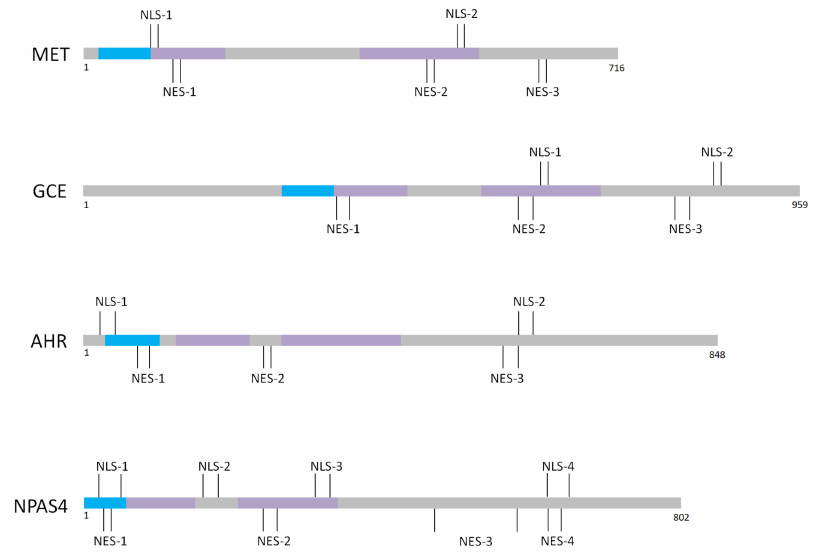
Figure 3. Schematic representation of documented NLSs / NESs distribution within the MET [19], GCE [20], AHR [35,40–42] and NPAS4 [21] proteins. bHLH domains are shown in blue, PAS